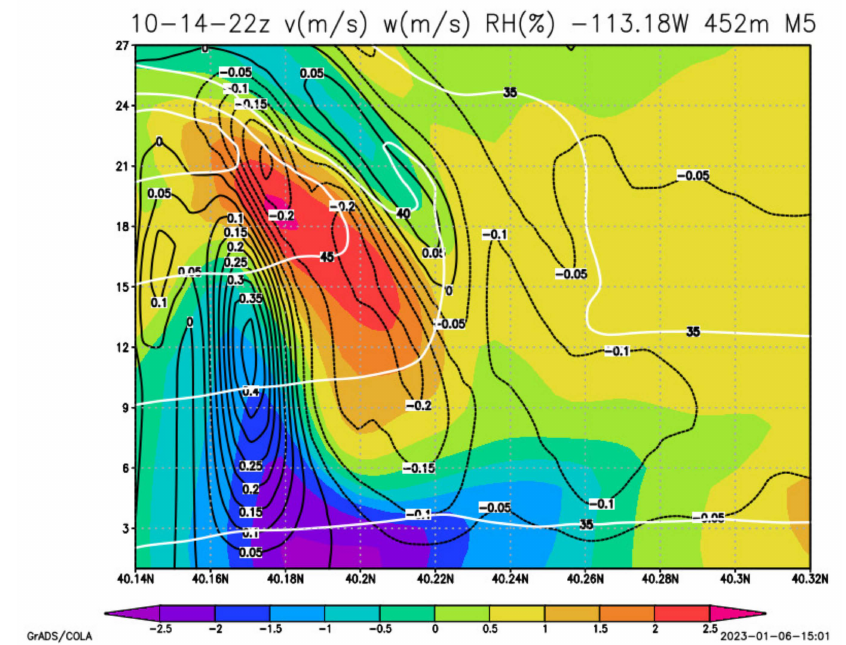
Figure 25. Model MS5 shaded v-wind component (m/s), RH (%) in white contours, and vertical motion w (m/s) in black contours for the cross section along − 113.18 W shown in the previous Figure 24. Vertical units are half-sigma levels, with level 15 at 528 m AGL, level 20 at 749 m AGL, level 25 at 1010 m AGL, and level 27 at 1129 m